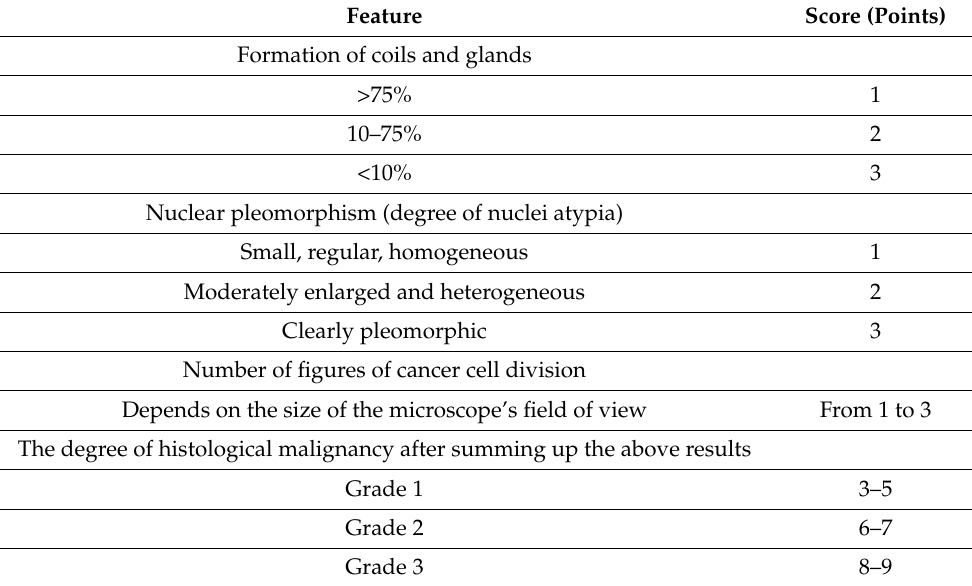
Table 3. Assessment of the degree of histological malignancy [75].